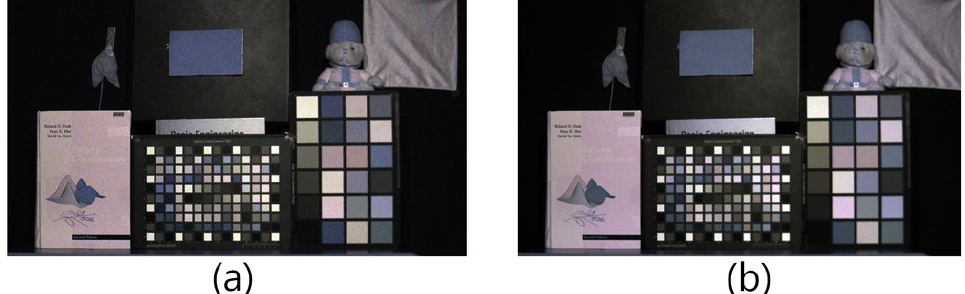
Figure 14. Result of the achromatic NIR band (above 800 nm) component removal (incandescent 5 lx). ( a ) Optical filtered image; ( b ) first step of the proposed